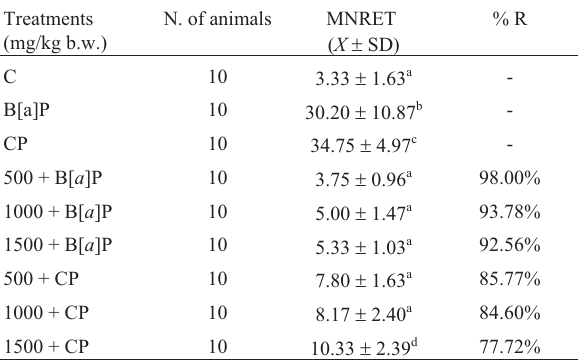
Different letters indicate statistical significance. X (cid:2) SD, mean (cid:2) standard deviation; C, distilled water; B[ a ]P, benzo[ a ]pyrene; CP, cyclophospha- mide; p <0.05, Statistical analysis was done using one-way ANOVA and Tukey’s Test.